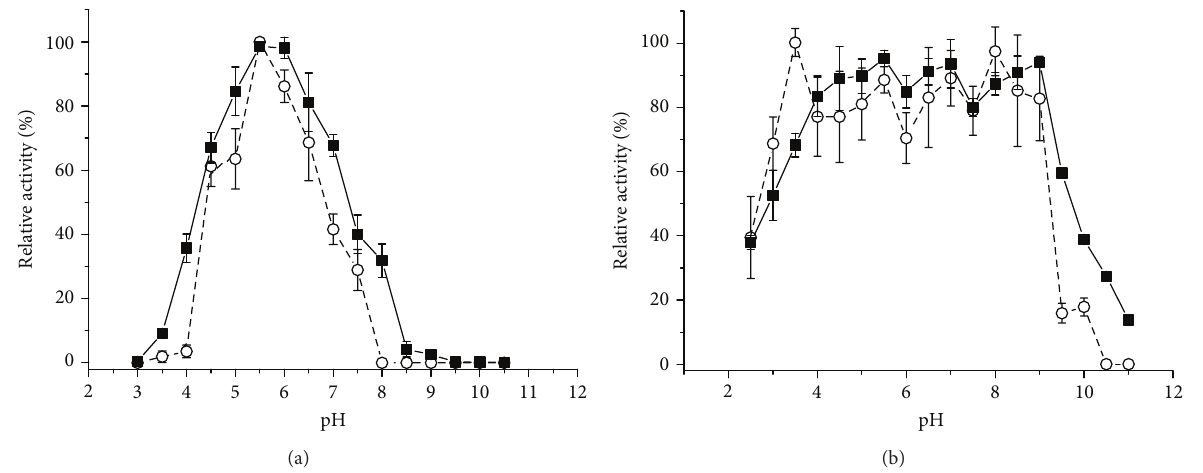
Figure 4: Effect of pH on the activity of the endoglucanases from the crude extract from M . heterothallica F.2.1.4. (a) ( ◼ ) SSCWB and ( I ) SmCP, respectively. Effect of the pH on the stability of the endoglucanases. (b) ( ◼ ) SSCWB and ( I ) SmCP, respectively.